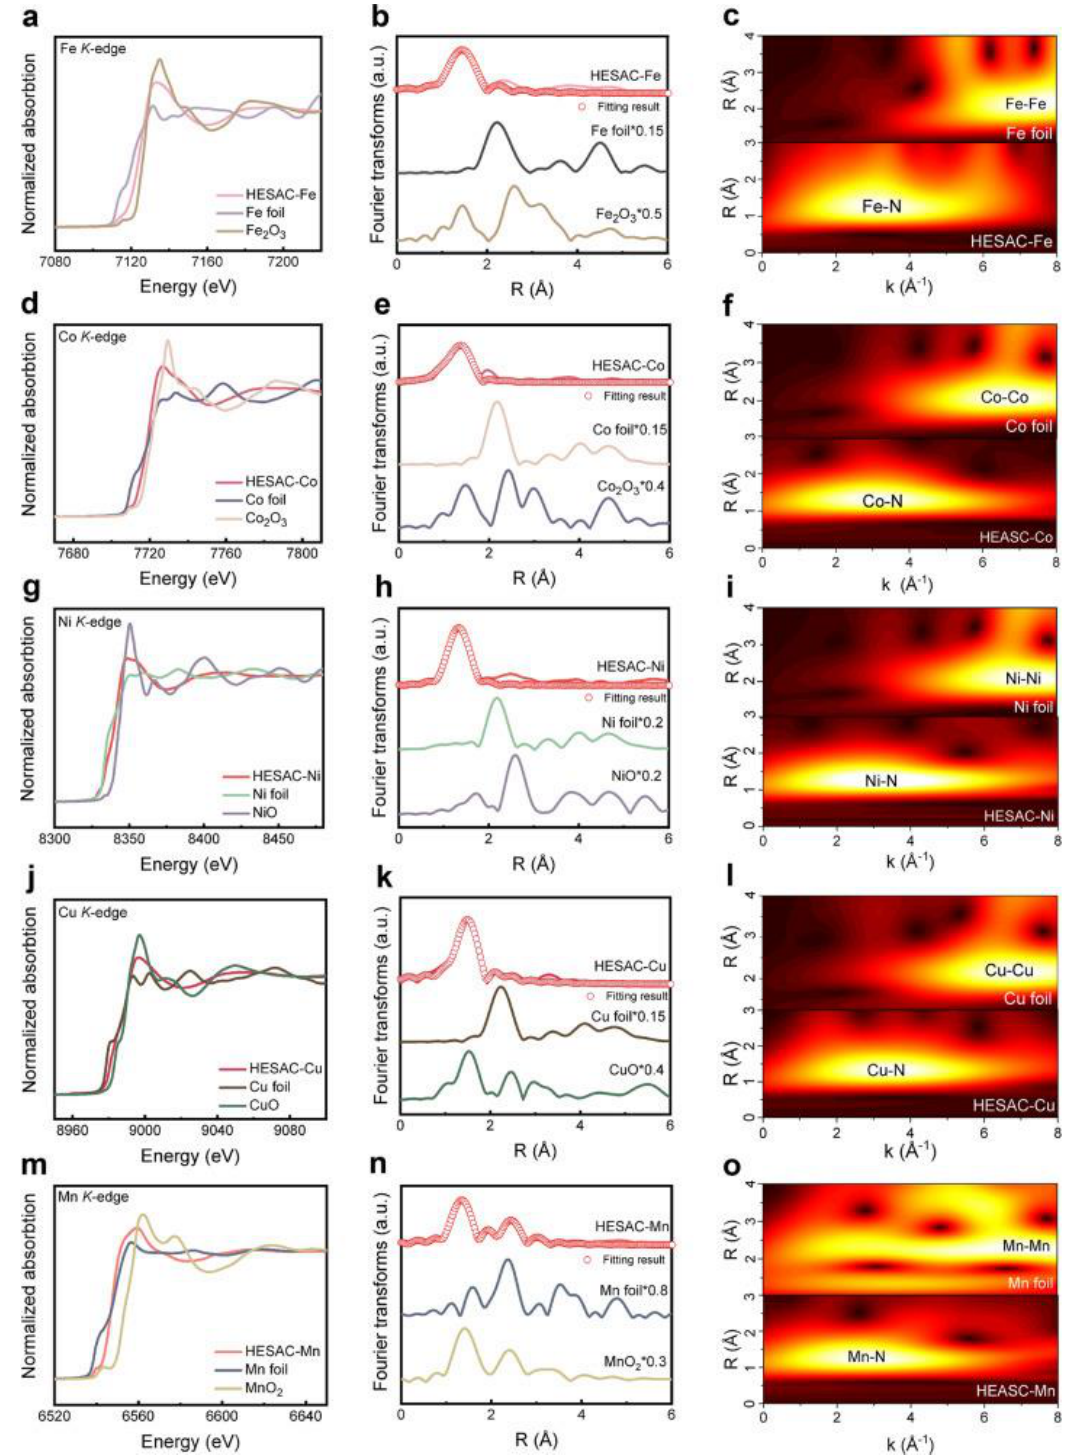
Figure 20. XANES and EXAFS data of the prepared binary high-entropy alloy (FeCoNiCuMn). ( a , d , g , j , m ) XANES spectra of (Fe K-edge), Co K-edge, Ni K-edge, Cu K-edge, and Mn K-edge of the binary high-entropy alloy. ( b , e , h , k , n ) and ( c , f , i , l , o ) WT of the EXAFS signals of the quaternary high- entropy alloy (FeCoNiCuMn) and the reference sample, respectively. (Reprinted with permission from [280]. Copyright 2022, Springer Nature Limited).